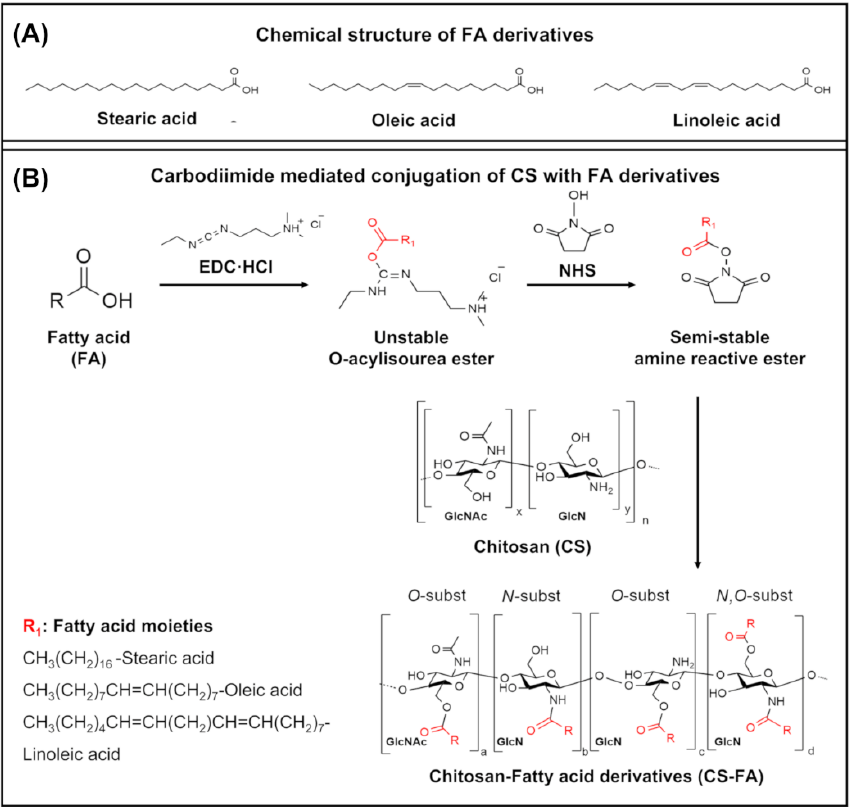
Figure 1. Chemical structure of FA ( A ) Possible reaction products of chemical conjugation mechanism of CS with FA derivatives via carbodiimide mediated coupling reaction ( B ).